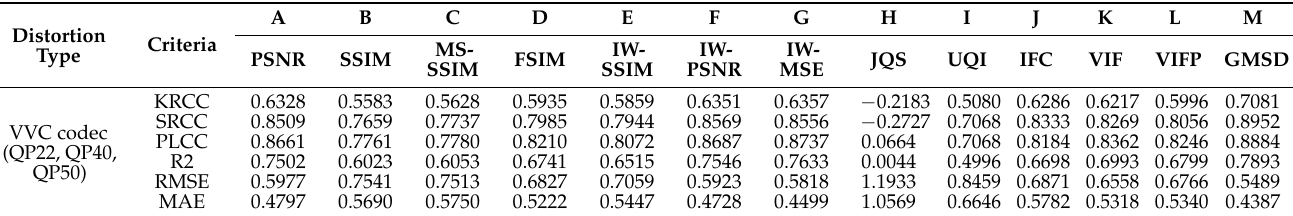
Table 5. Performance comparison of objective quality metrics on the LF